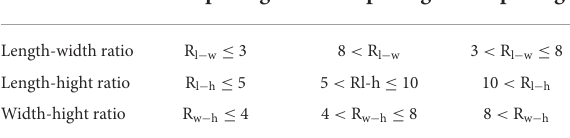
TABLE 1 The definitive criteria of different delivery